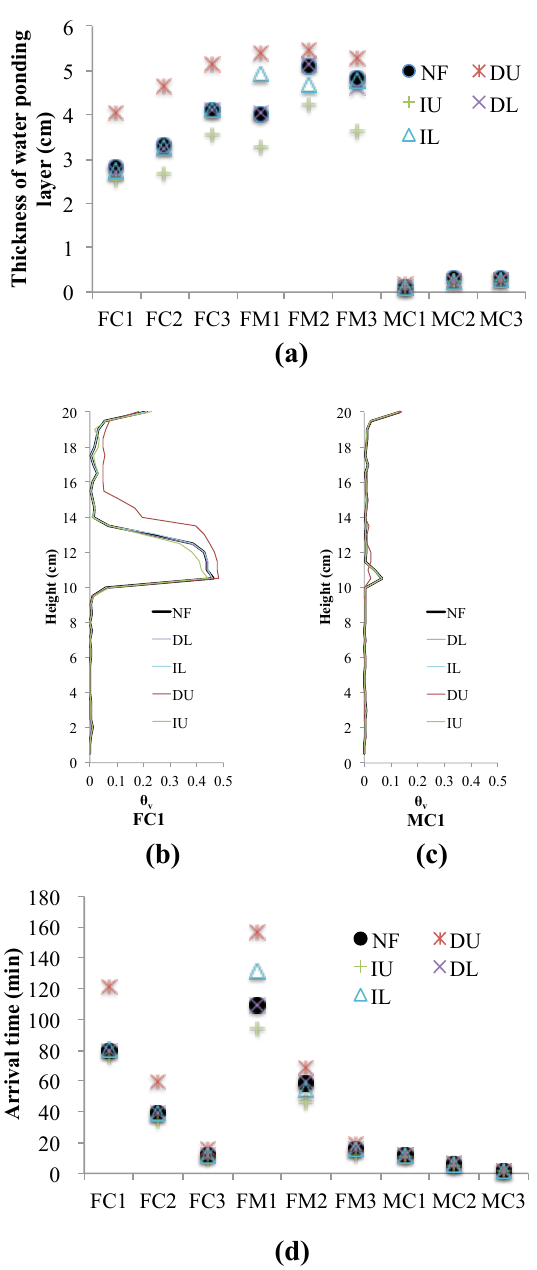
Figure 8. Influence of grain size fluctuations on the thickness of the water ponding layer (a) , water content profiles (b, c) and arrival time at the snow base (d) . NF: no fluctuation, IU: increase 0.1mm for the upper layer, DU: decrease 0.1mm for the upper layer, IL: increase 0.1mm for the lower layer and DL: decrease 0.1mm for the lower